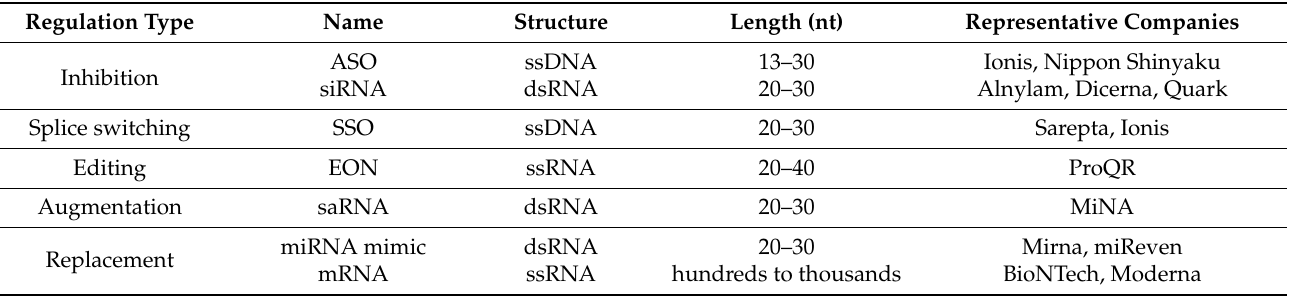
Table 1. Classification of nucleic acid